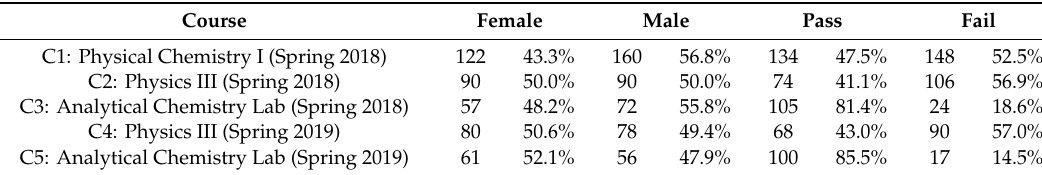
Table 1. Gender and target class distribution of the